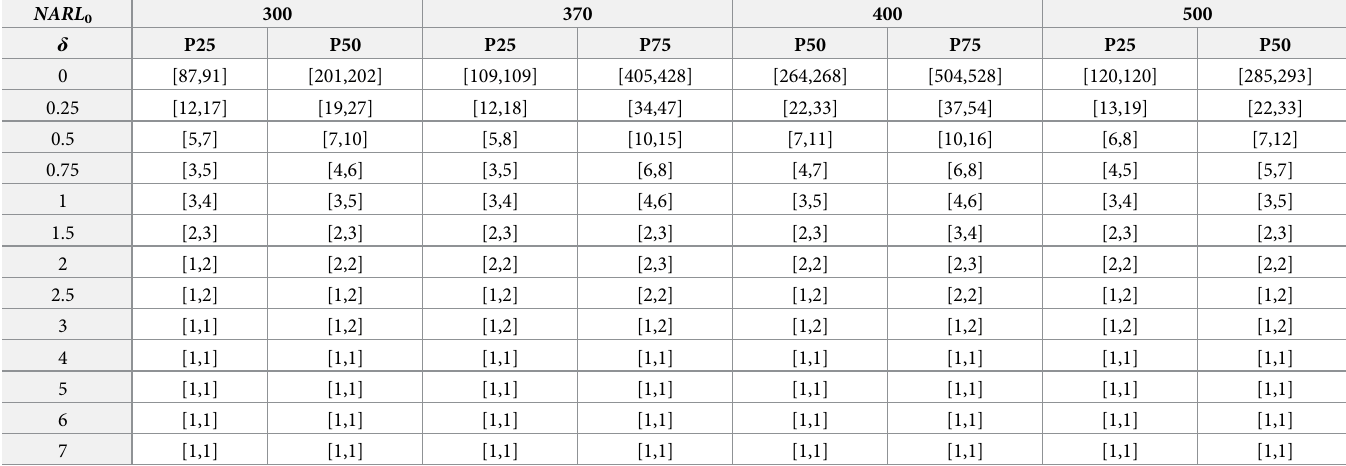
Table 5. The neutrosophic percentile points of the proposed NCUSUM � X chart when n N 2 [3, 5], k N 2 [0.4, 0.5] for different nominal NARL